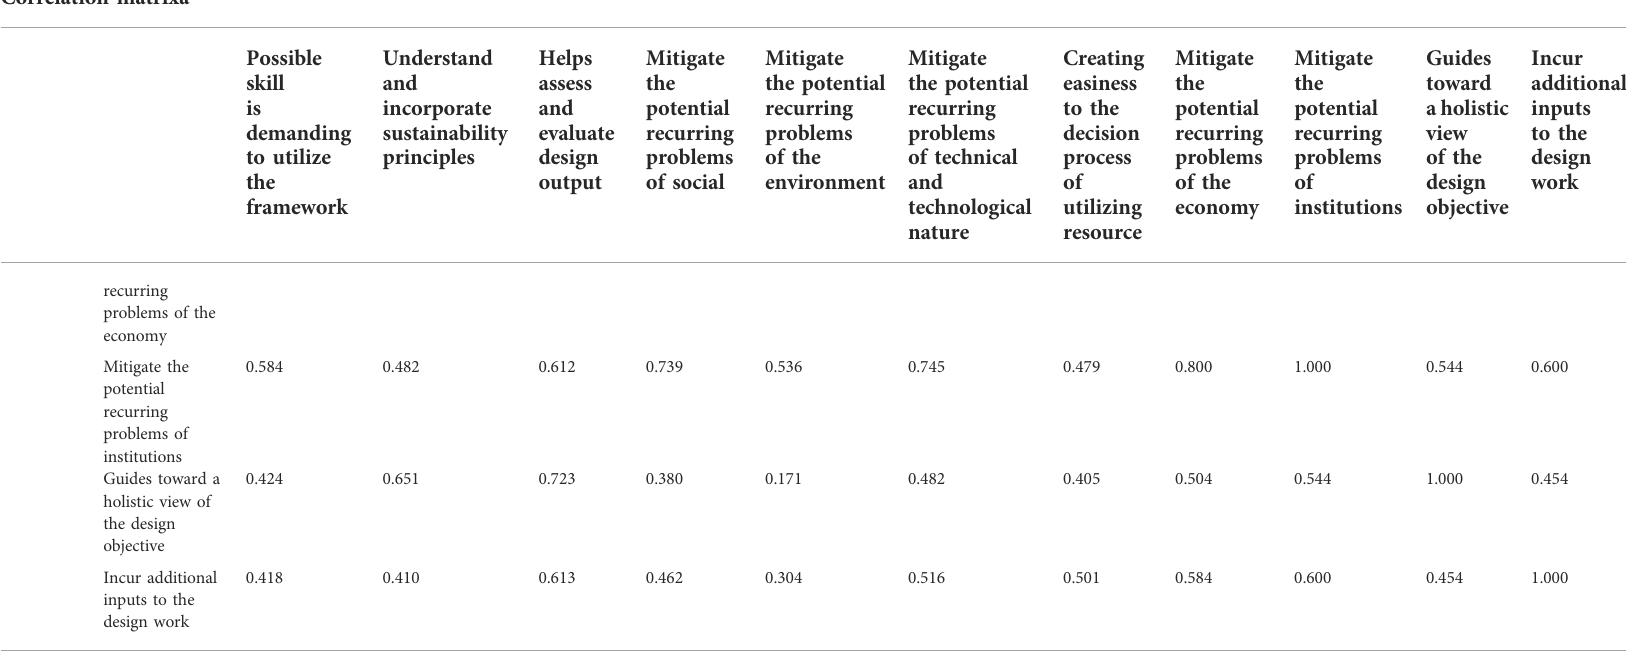
TABLE 5 ( Continued ) Correlational matrix among the factors using the Oblimin rotation